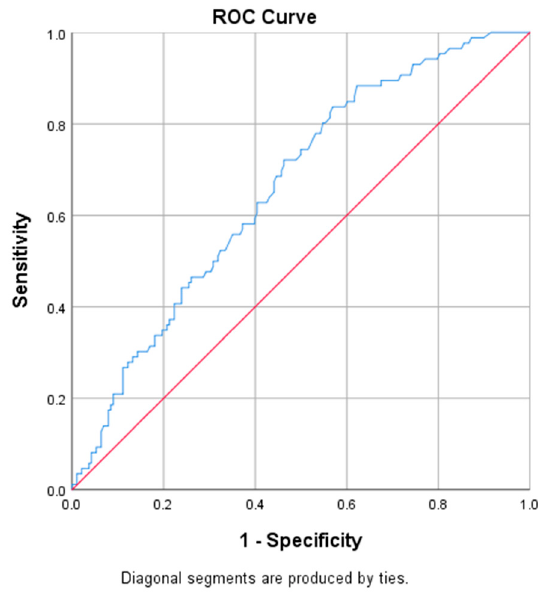
Figure 2. Hypertension: respiratory event index (REI) receiver operating characteristic (ROC) curve.